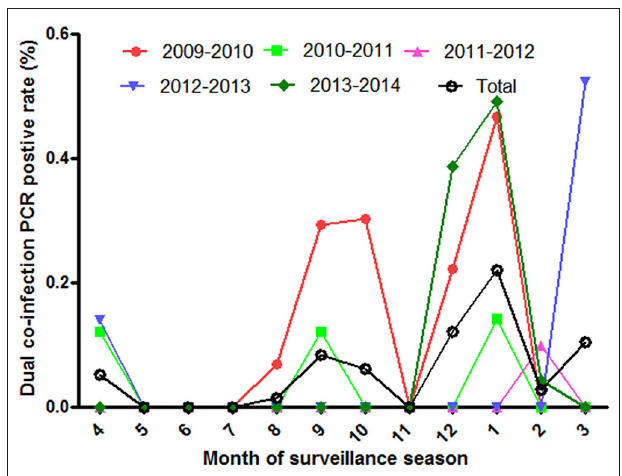
FIGURE 4 | The positive rate of influenza co-infection in different surveillance months from 2009 to 2014.